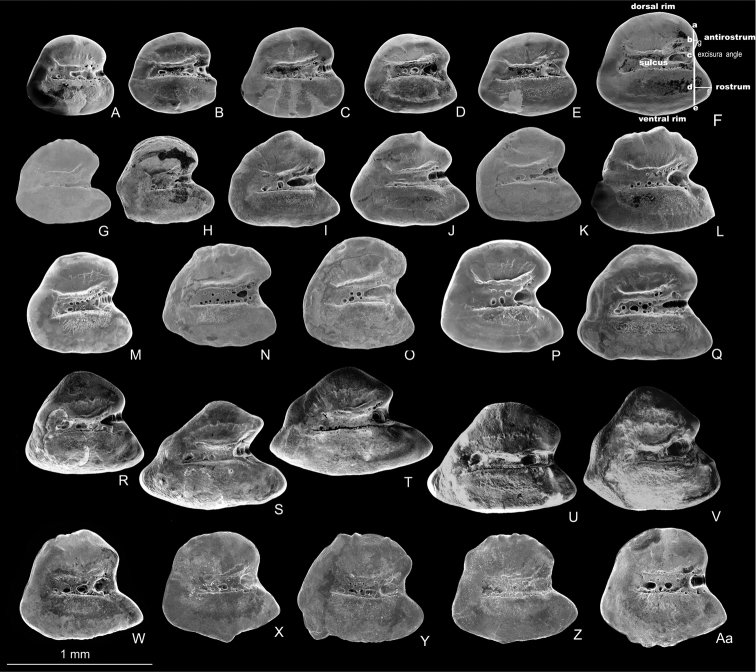
Left otoliths (medial view) of Aphanius isfahanensis (A–F), Aphanius farsicus (G–L), Aphanius sophiae (M–Q), Aphanius vladykovi (R–V) and Aphanius arakensis (W–Aa). Otolith terminology and taxonomic most informative morphometric distances are indicated in Fig. 3F and include height of antirostrum (a–c), height of rostrum (c–e), length of antirostrum (b–g), and length of rostrum (d– f). SEM pictures.